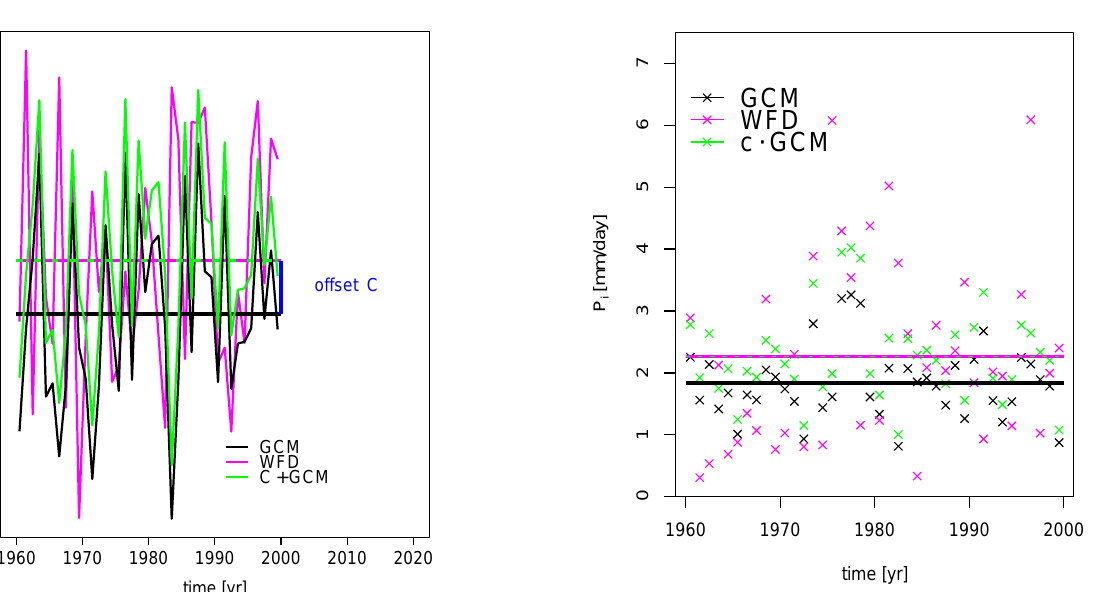
Fig. 1. April temperature means for the example grid cell during the reference period. The offset between observational and simu- lated data, C , in the reference period is illustrated, together with the shifted GCM data. The horizontal lines refer to the associated long-term means.